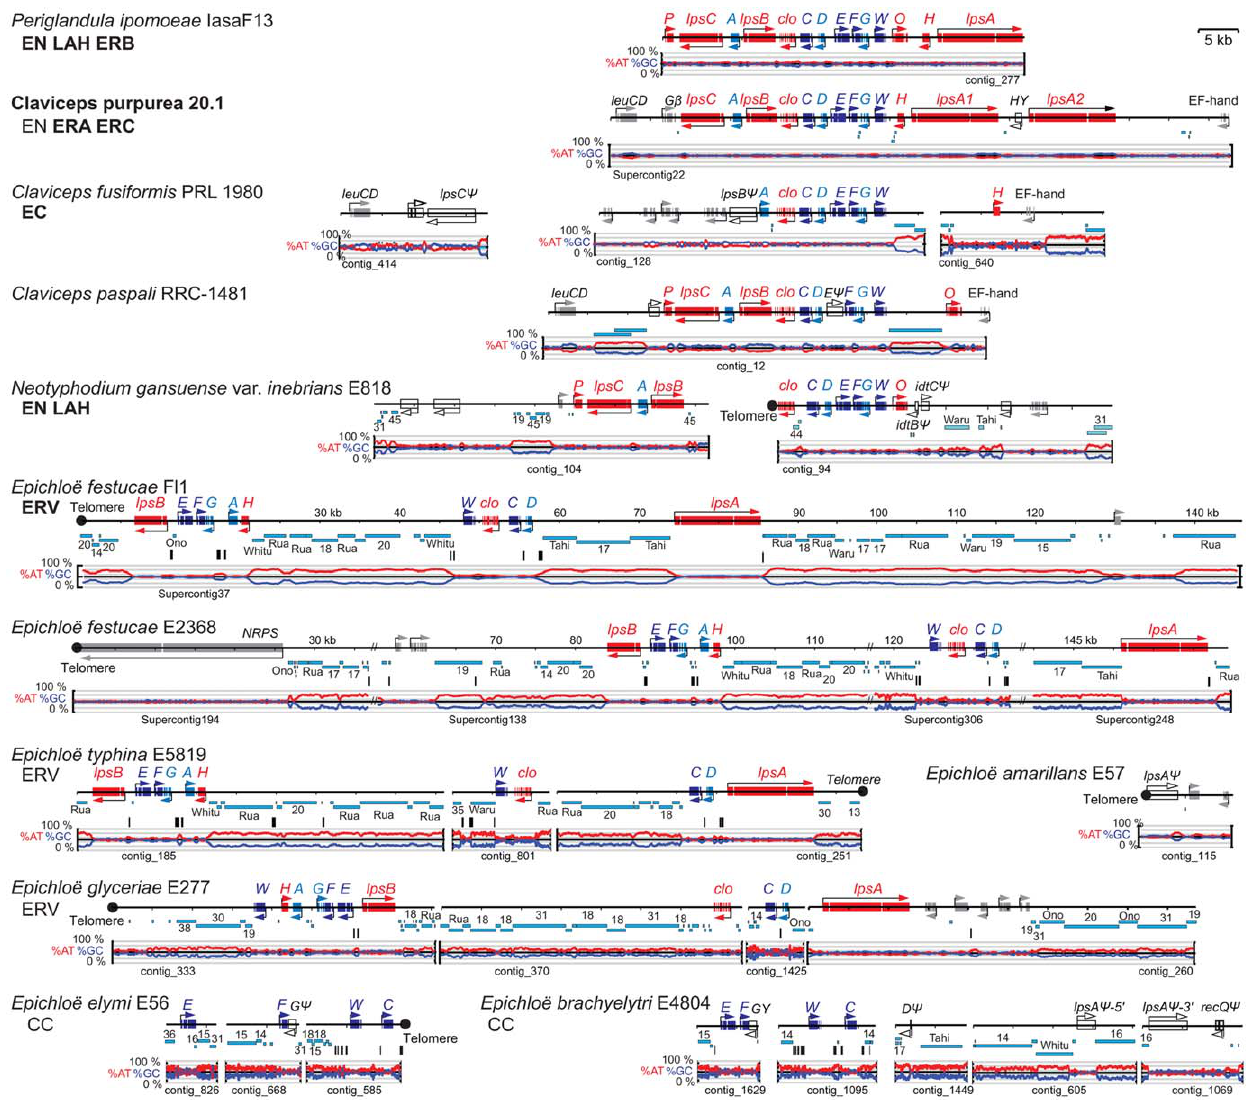
Figure 6. Structures of the ergot alkaloid biosynthesis loci ( EAS ) in sequenced genomes. Tracks from top to bottom of each map represent the following: genes, repeats, MITEs, and graphs of AT (red) and GC (blue) contents. Each gene is represented by one or more boxes representing the coding sequences in exons, and an arrow indicating the direction of transcription. Double-slash marks (//) indicate sequence gaps within scaffolds of the assembled E. festucae genome sequences. Closed circles indicate telomeres, and distances from the telomere on the E. festucae map are indicated in kilobasepairs (kb). Cyan bars beneath each map represent repeat sequences, and are labeled with names or numbers to indicate relationships between repeats in the different species. Vertical bars beneath the repeat maps indicate MITEs. Gene names are abbreviated A through P for easA through easP , W for dmaW , and clo for cloA . Genes for synthesis of the ergoline ring system (skeleton) are shown in dark blue for the steps to chanoclavine-I ( W , F , E , and C ), and in light blue ( D , A , and G ) for steps to agroclavine. Genes for subsequent chemical decorations are shown in red ( clo , H , O , P , lpsA , lpsB , and lpsC ). Identifiable genes flanking the clusters are indicated in gray, and unfilled arrows indicate pseudogenes. The major pathway end-products for each strain are listed below each species name, abbreviated as indicated in Figure 2, and in bold for those confirmed in this study. Note that LAH is a reported product of C. paspali , but the sequenced strain is predicted not to synthesize it due to a defective easE gene.